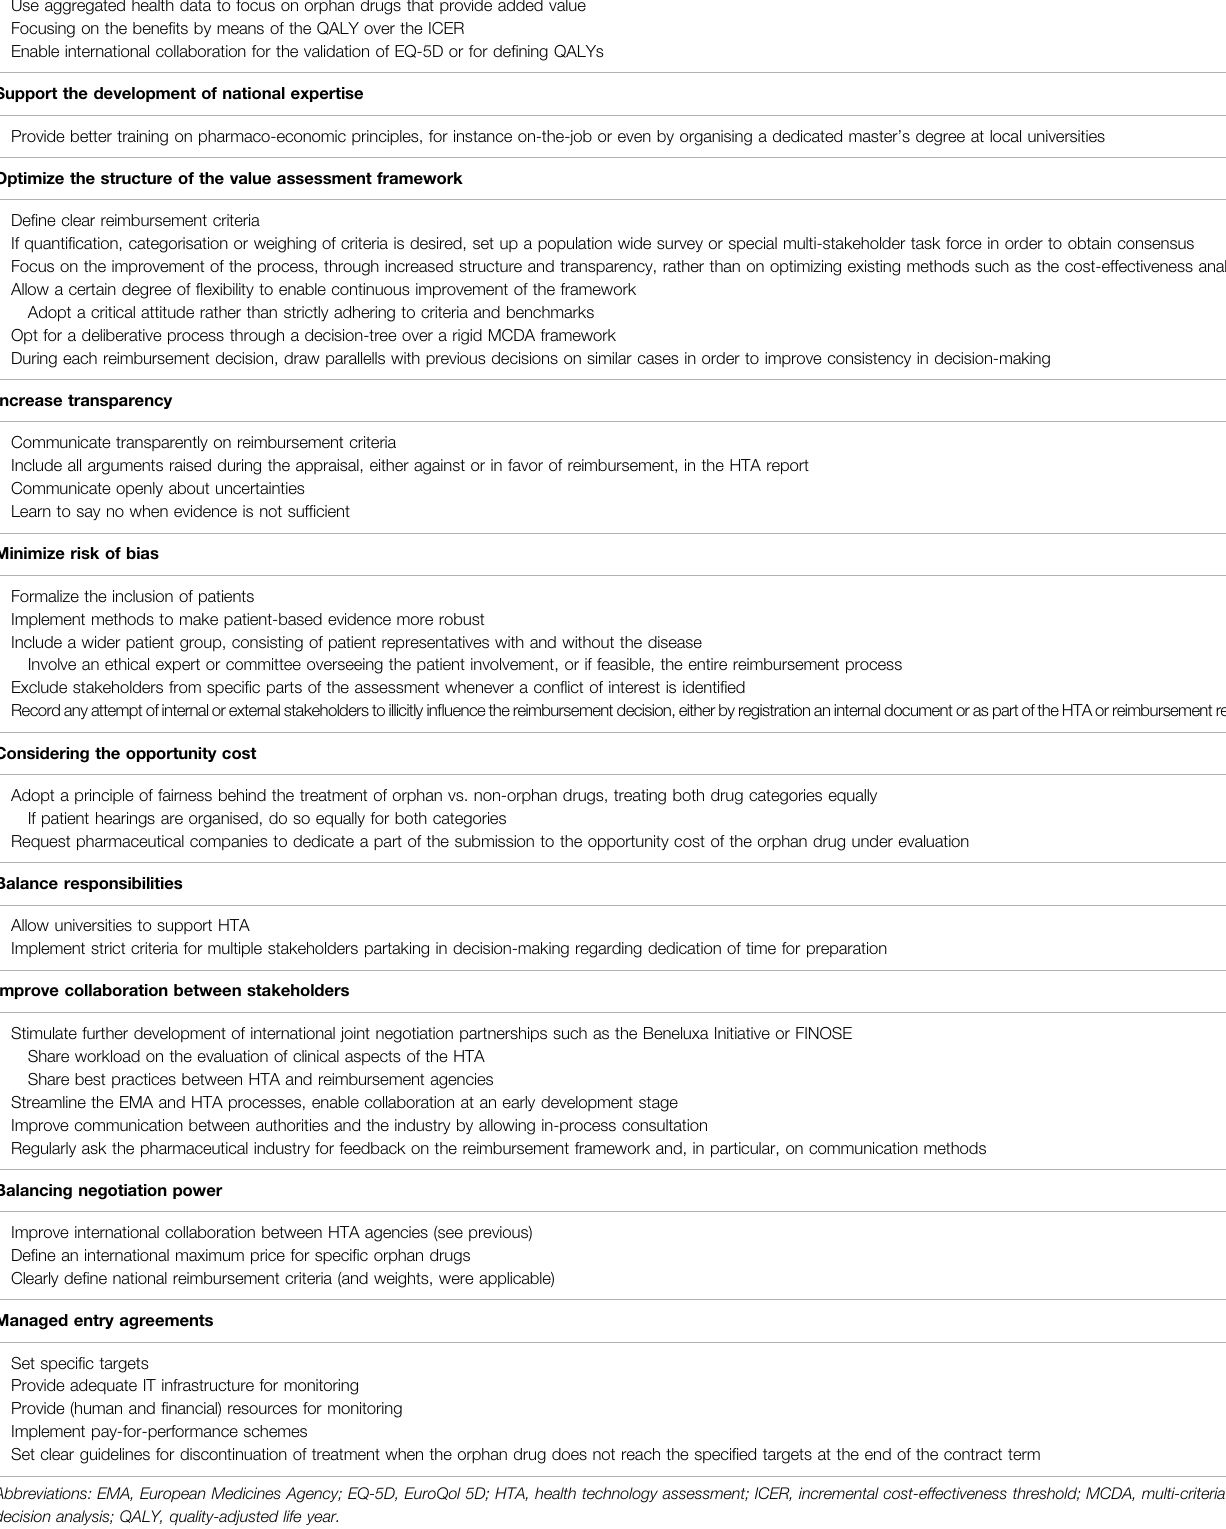
Frontiers in Pharmacology |